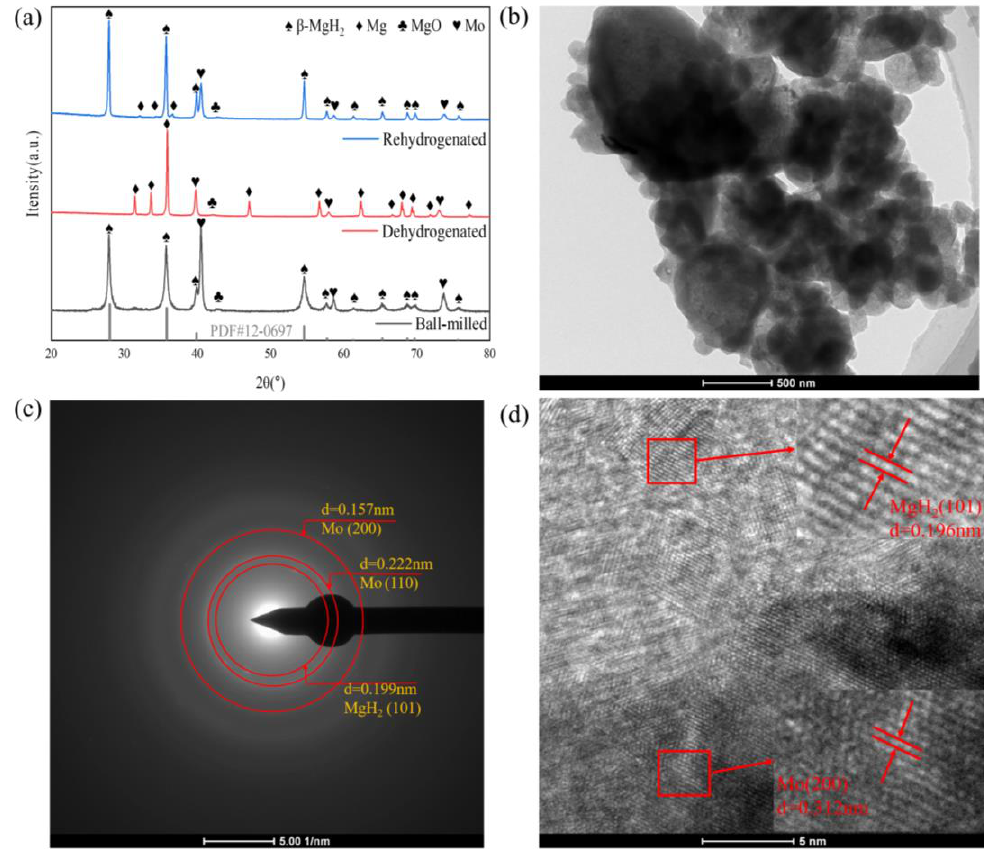
Figure 4. ( a ) XRD patterns of MgH 2 -7wt%Mo ball-milled, dehydrogenated, and rehydrogenated; ( b ) TEM image; ( c ) SAED pattern; and ( d ) HRTEM image of ball-milled MgH 2 -7wt%Mo.